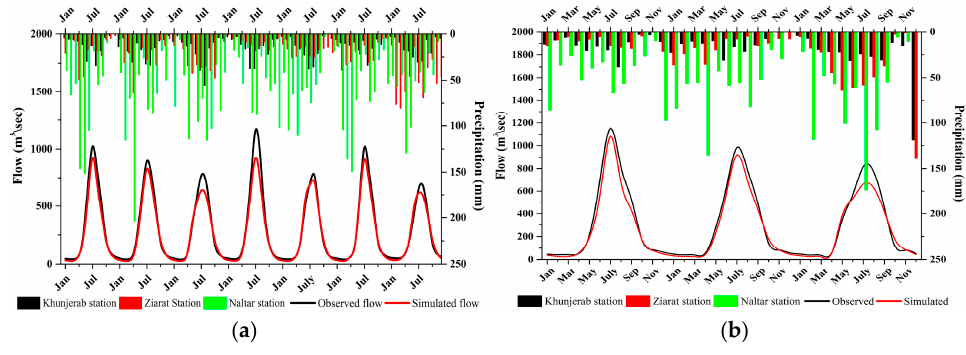
Figure 6. Monthly calibration ( a ) and validation ( b ) for 1998–2004 and 2008–2010. Table 6. Simulated daily average water balance components and their values.